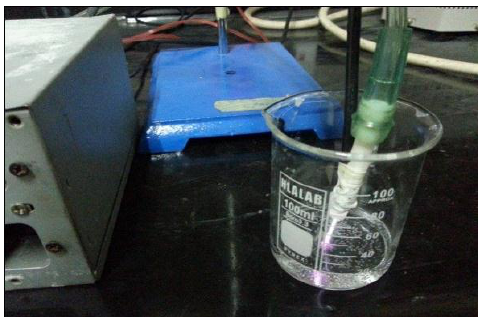
Fiq.1: Plasma jet liquids treatment.